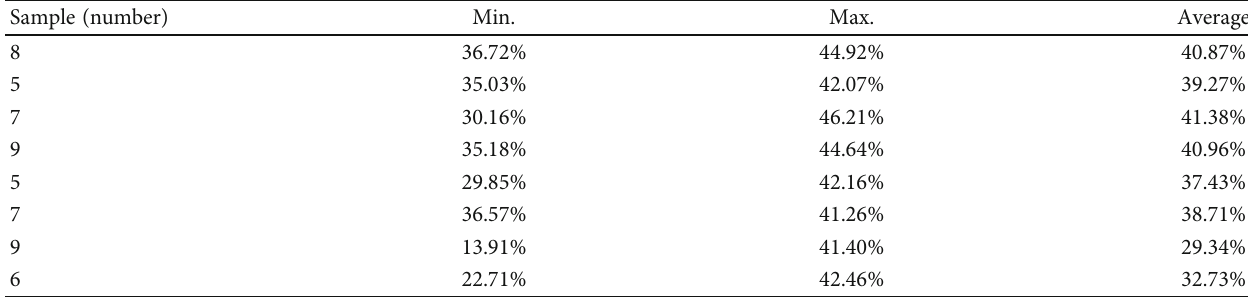
Figure 13: Relationship between the SSA and the total pore volume. Table 3: Statistics of brittleness index of all wells in the study